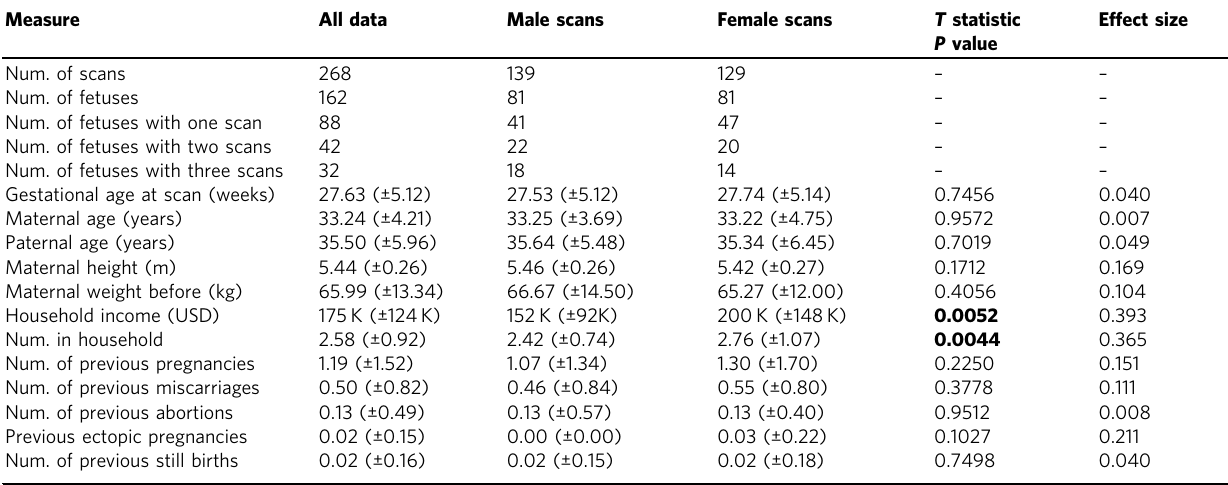
Table 4 Summary of the fetal imaging data and cohort demographics (covering a range from a minimum of 18.0 to a maximum of 36.8 gestational weeks) used in this